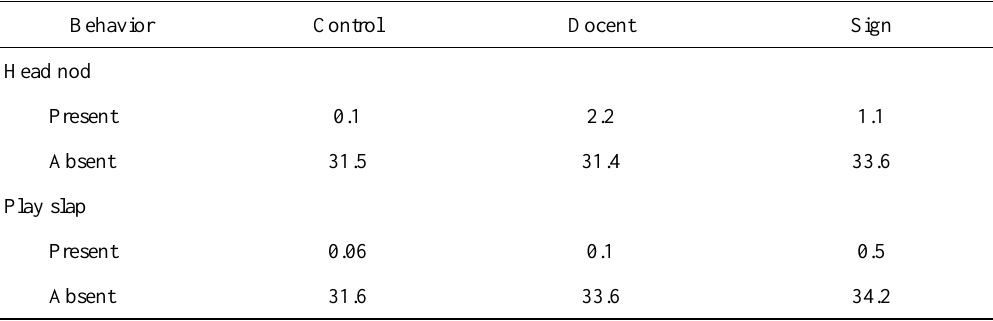
Percent of Intervals Containing Affinitive Visitor Behaviors Behavior Control Docent